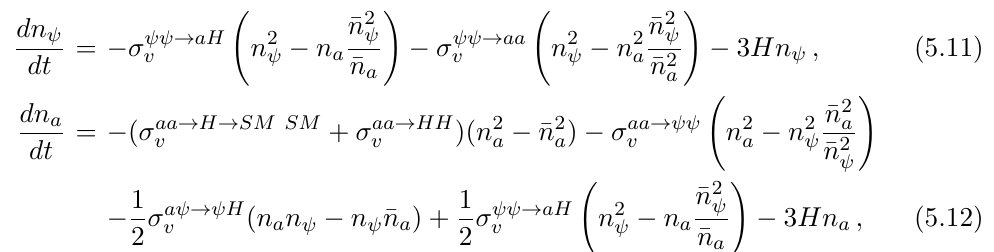
Figure 10. Tree-level Feynman diagrams for DM (co)annihilation: a)-b) for c)-e) for aa annihilation and f) for ψ − a